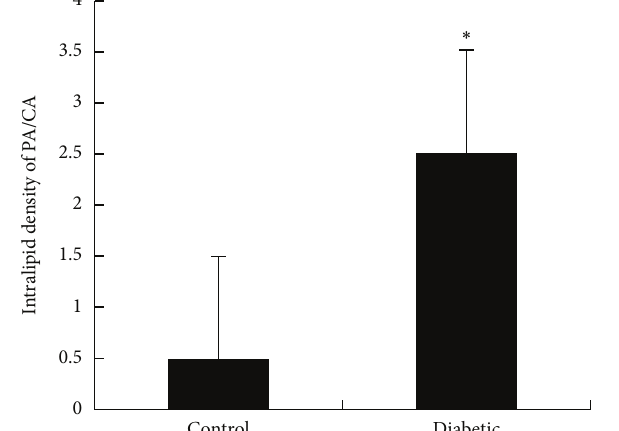
Figure 5: Ratio of Intralipid particle density between the PA and CA of the glomerular capillaries ( ∗ 𝑃 < 0.01 ). Results from 𝑛 = 6 rats; 5 glomerular capillaries were examined in each rat. PA: periendothelial area and CA: central area.